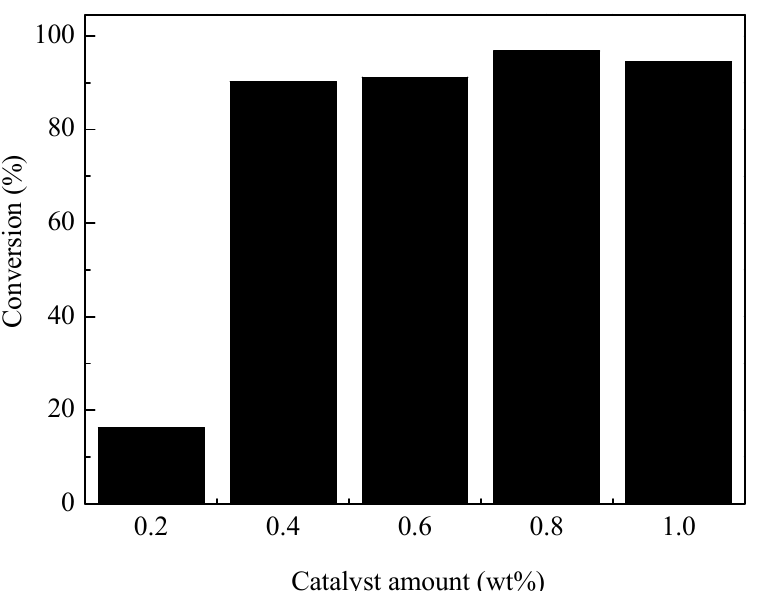
Figure 4. Effects of catalyst amount on the biodiesel conversion. Reaction conditions: a molar ratio of 12:1, an NaOH catalyst ranging from 0.2 wt % to 1.0 wt %, a reaction time of 2 min, a reaction temperature of 65 °C, and a microwave power of 600 W.